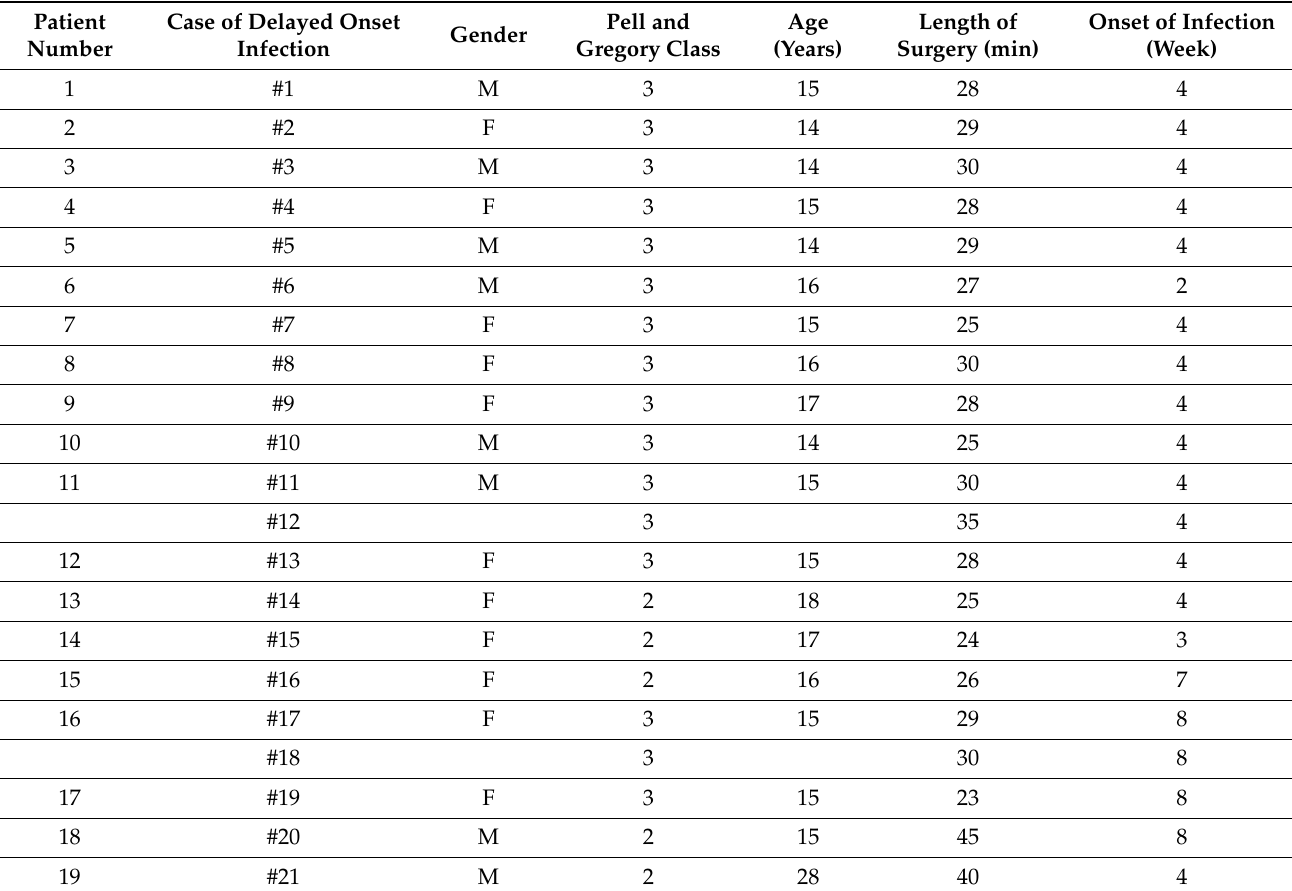
Table 1. Characteristics of the patients with delayed onset infection.